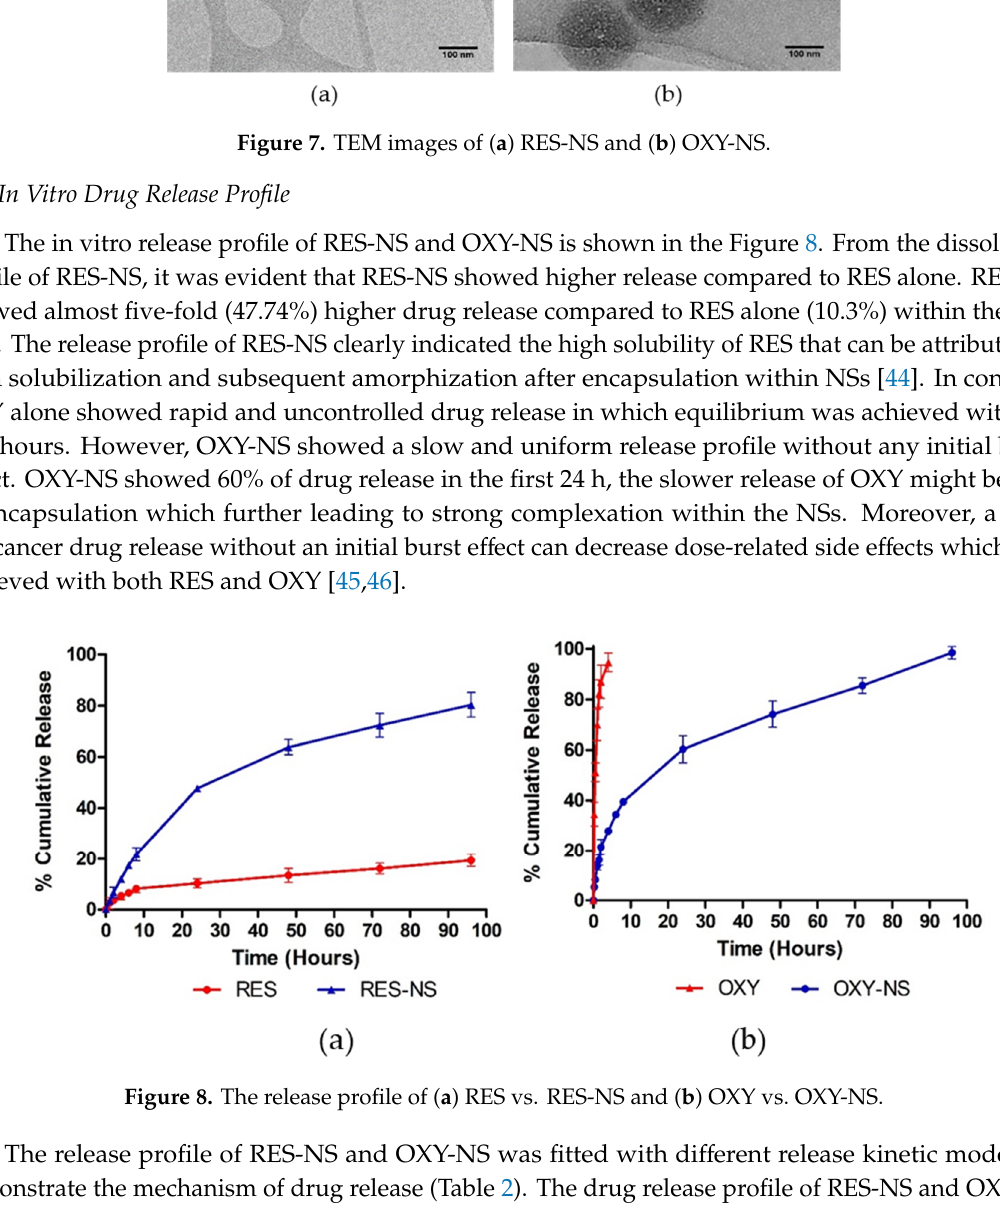
Table 2. Release kinetic models for RES-NS and OXY-NSs.